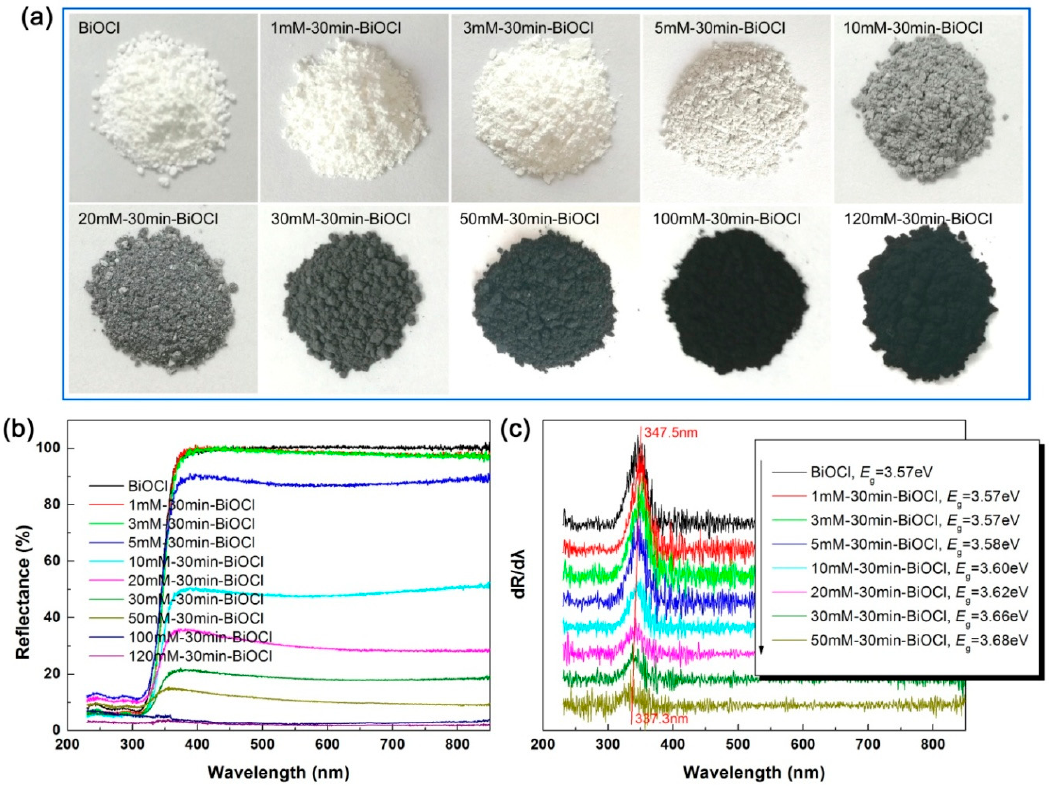
Figure 2. Apparent colors ( a ), UV-vis diffuse reflectance spectra ( b ), and first derivative curves of the diffuse reflectance spectra ( c ) of pristine and NaBH 4 -treated BiOCl samples with different concentrations.